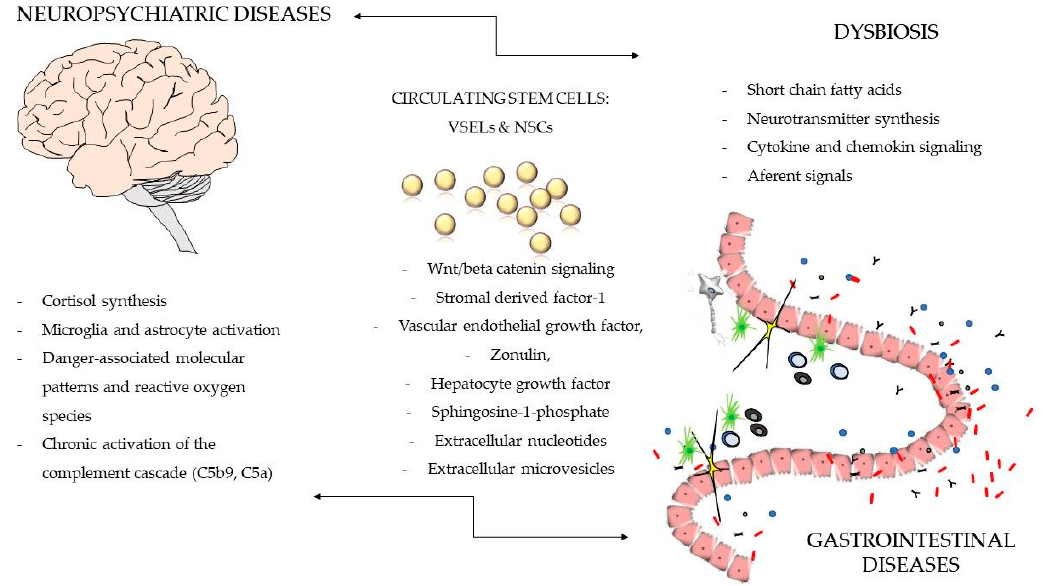
Figure 1. The bidirectional signaling within the GBA with the involvement of sterile inflammation of the brain and actions of microbiota and circulating adult stem cells. For details, see the text.